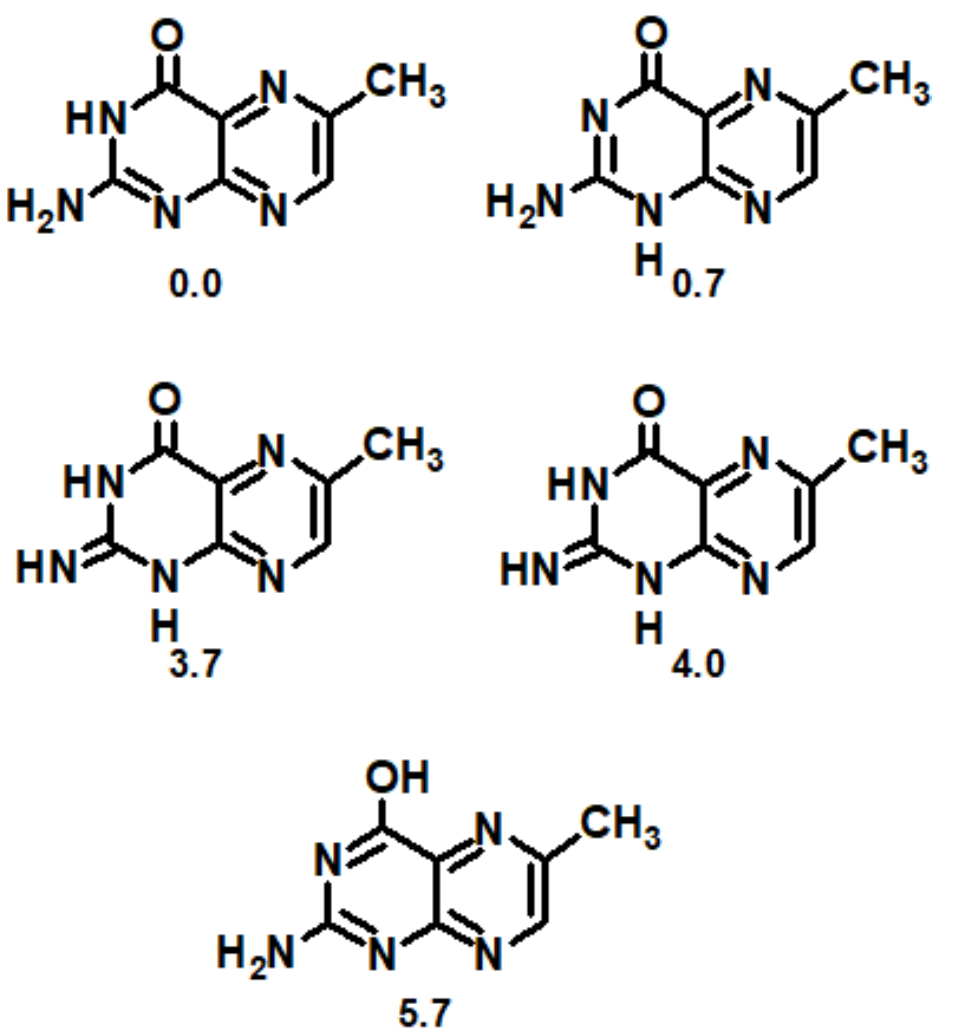
Figure 8. Low-energy tautomers of 6-methylpterin (6-Mep) with relative energies (in kcal mol − 1 ) according to the B3LYP/6-31G(d,p) method [129].